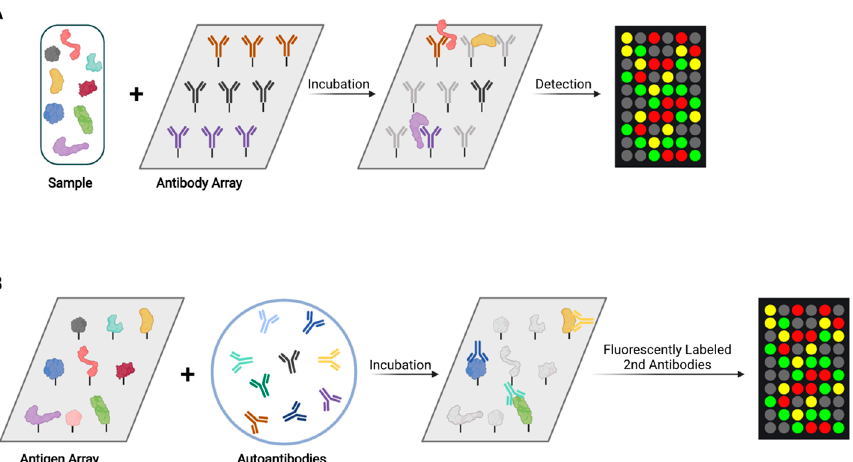
Figure 3. Schematic overview of antibody array and antigen array analyses. ( A ) In an antibody array, each spot contains one type of antibody and each array is incubated with one test sample. For protein quantification, proteins are fluorescently labeled (either directly or indirectly) and incubated with an antibody array. ( B ) In an antigen array, each spot contains one purified protein and each array is incubated with one test sample. For protein quantification, fluorescently labeled secondary antibodies are incubated with an antigen array.